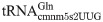
Codon table and the anticodon loop of tRNAs specific for Gln, Lys, and Glu which contain cmnm5s2U (Gln) or mnm5s2U (Lys and Glu) as wobble nucleoside in bacterial tRNAs.Above the third column (second codon base A) the anticodon stem and loop of the tRNAs containing the (c)mnm5s2U in position 34 is shown (denoted in red cmnm5s2). Position 36 of the anticodon is color coded with Green G36 being position 36 for tRNAcmnm5s2UUGGln, red U36 for tRNAmnm5s2UUULys, and blue C36 for tRNAmnm5s2UUUGlu. Similar color code is denoted for the modified nucleosides present in position 37 in the corresponding tRNAs. N denotes G, A or C, respectively, for first nucleoside in the relevant codons read by these tRNAs. Note that these tRNAs are rich in U, which is a poor stacker [24] making the anticodon very flexible especially if the modifications is absent and this is especially true of tRNAmnm5s2UUULys. In the codon table the letters outside the box, to the left, above, and to the right indicate the first, second, and third position of the codon. Circles connected by a line, or a single circle, represent one tRNA species. A filled circle indicates the capacity of that tRNA to base pair with the indicated codon, either by Watson-Crick or by wobble according to the revised wobble hypothesis [1]. Red and yellow circles indicate tRNAs that are sequenced at the RNA level while green circles represent tRNAs for which only a partial tRNA sequence is available. A red or green circle indicates efficient base pairing while a yellow circle indicates a restricted wobble. An open (white) circle is a base pairing that is not according to the revised wobble hypothesis. However, data in vivo from mutants where only this tRNA is left to decode all codons in the codon box, suggest that the tRNA in fact is able to read that codon [9, 25]. Data are compiled from Sprinzl data base (http://trnadb.bioinf.uni-leipzig.de/ and Modomics data base (http://modomics.genesilico.pl/). Mutations in mnmE or mnmG genes result in no formation of the (c)mnm5- group not only of the (c)mnm5s2U present in tRNAs specific for Gln, Lys and Glu but also cmnm5Um in tRNAcmnm5UAALeu and mnm5U34 in tRNAs specific for Arg and Gly. Mutations in mnmA results in no thiolation of cmnm5s2U34. a) The modifications in position 34 of tRNAcmnm5s2UUGGln from S. enterica are cmnm5s2U (80%) and mnm5s2U (20%) [10] and similar in E. coli [11] b) The majority of this tRNAGly contains mnm5U34 but there is also a small amount of cmnm5U34 [1].